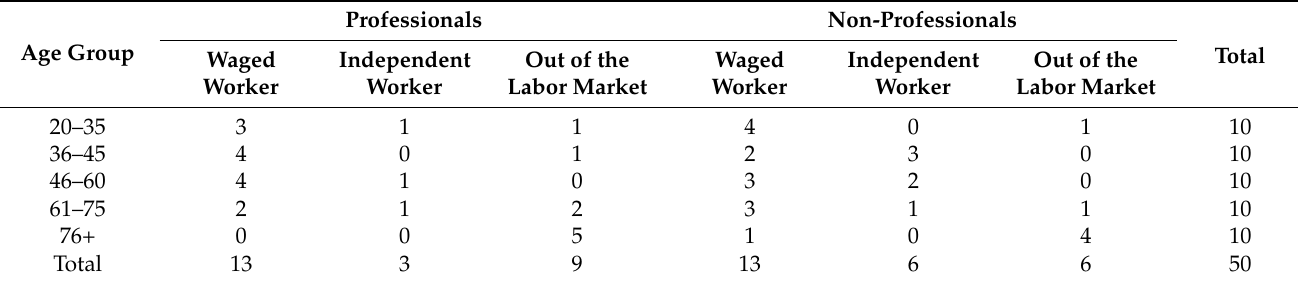
Table 1. Occupational situation according to age, by professionals and non-professionals.